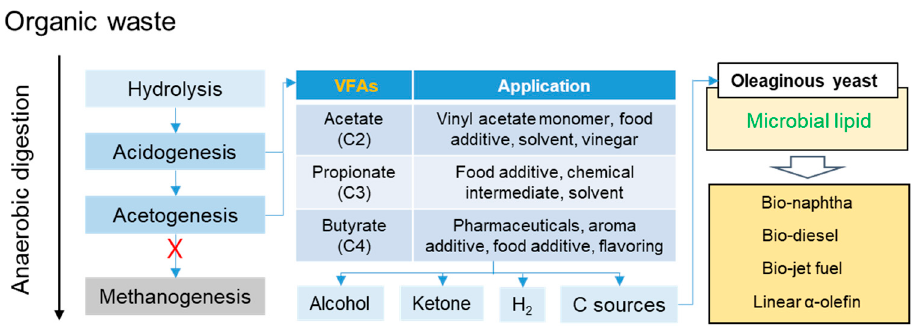
Figure 1. Product technology of VFAs and microbial lipid platforms .